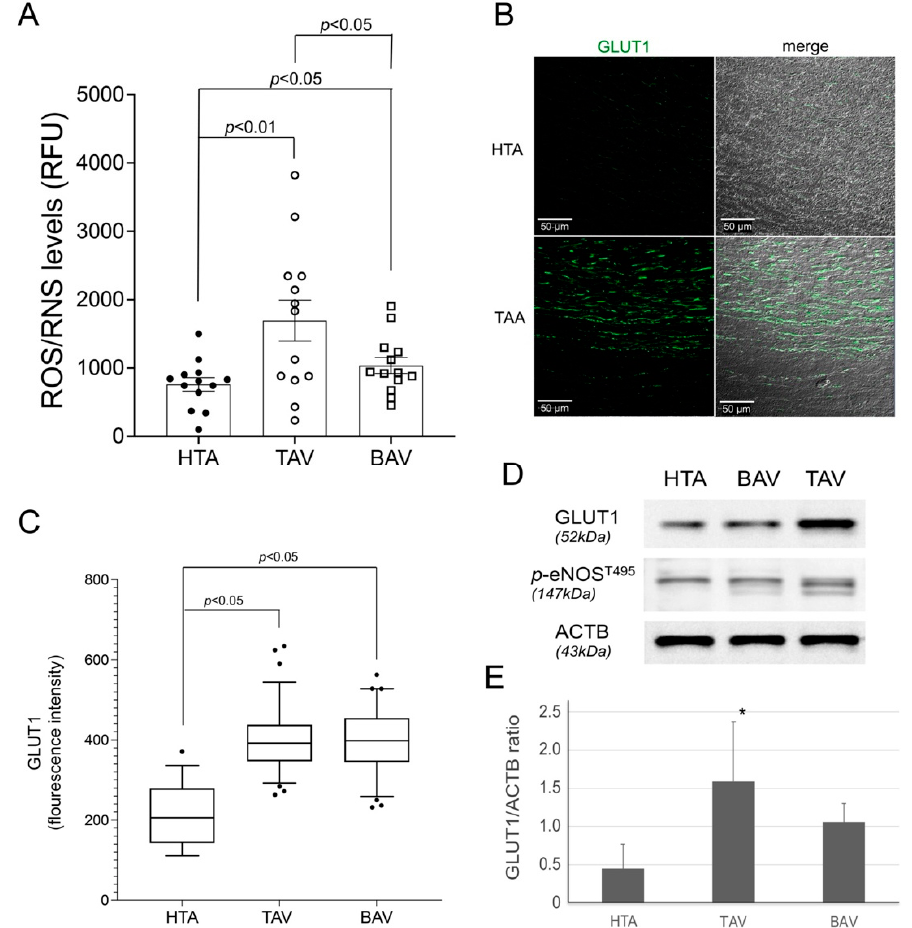
Figure 2. ROS/RNS and GLUT1 expression was detected in aneurysm specimens. Measurement of ROS/RNS and GLUT1 protein levels indicated activation during hypoxic stress in aneurysm sections. ( A ) ROS/RNS measurement by OxiSelect™ in protein extracts of healthy aortic (HTA, n = 13) and aneurysm (TAV, n = 13, BAV, n = 13) specimens. RFU, relative fluorescence units. GLUT1 expression was measured in all aortic samples by immunofluorescence (IF, B , C ) and confirmed in selected samples (13 samples of each group) by Western blot ( D , E ). ( B ) Representative image of GLUT1 protein (green) expression stained by IF. Scale bar, 50 µm. ( C ) Statistical analysis for GLUT1 protein expression in HTA (4092 cells), compared to TAA-TAV (18,293 cells) and TAA-BAV (11,543 cells) specimens. ( D ) The blot shows representative GLUT1 and p -eNOS specific results, and the reference beta-actin (ACTB). ( E ) Statistical analysis for GLUT1 protein expression detected by Western blot is given (HTA, n = 13; TAV, n = 13; BAV, n = 13). * p < 0.05.